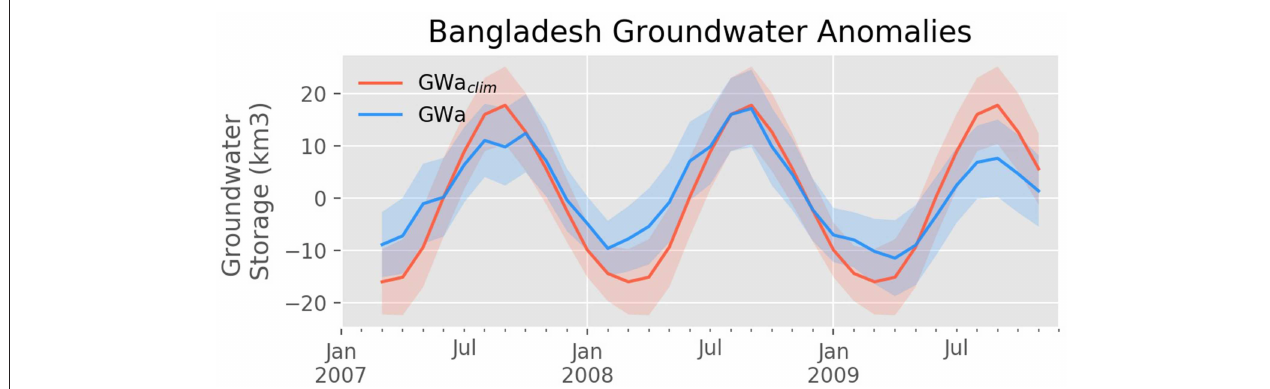
FIGURE 5 | Changes in groundwater storage with uncertainty for Bangladesh. The blue line indicates the monthly changes in groundwater storage and the red line indicates the corresponding monthly climatology. Shaded regions represent monthly groundwater uncertainty as computed by Equation (3).